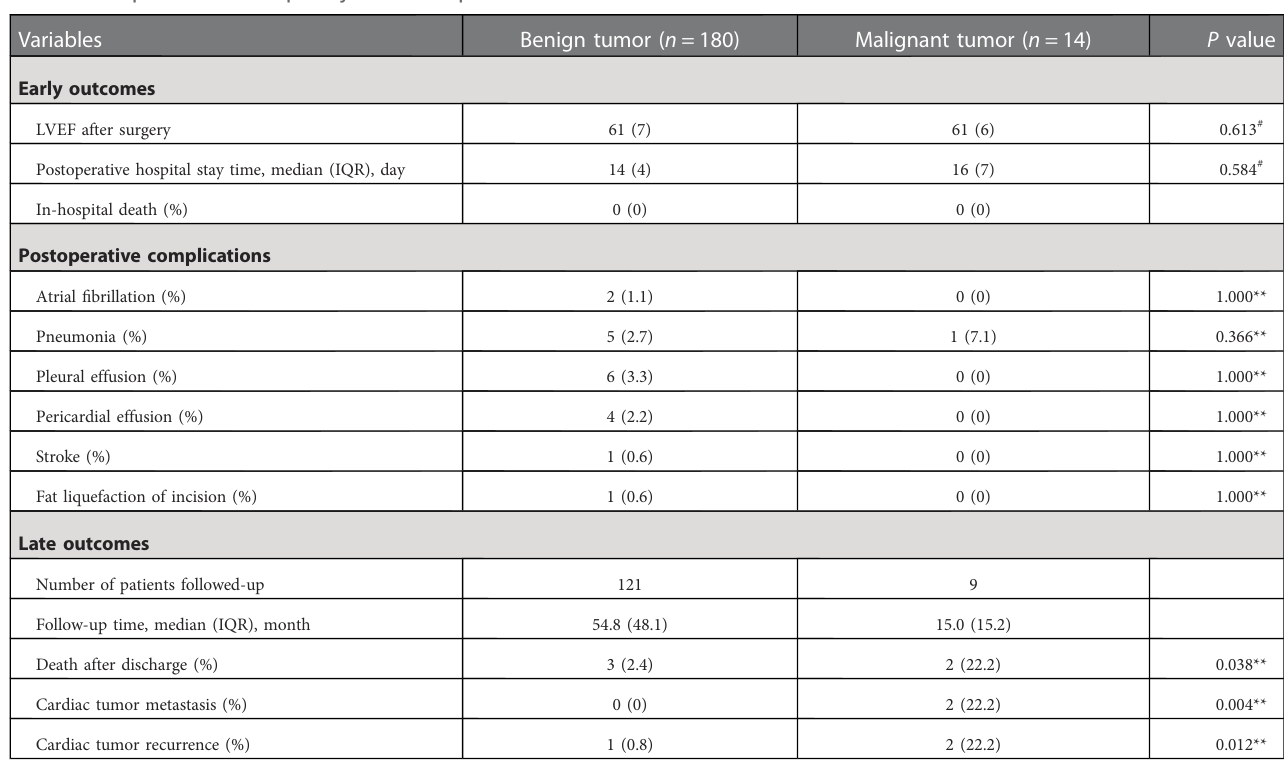
TABLE 5 Postoperative results of primary atrial tumor